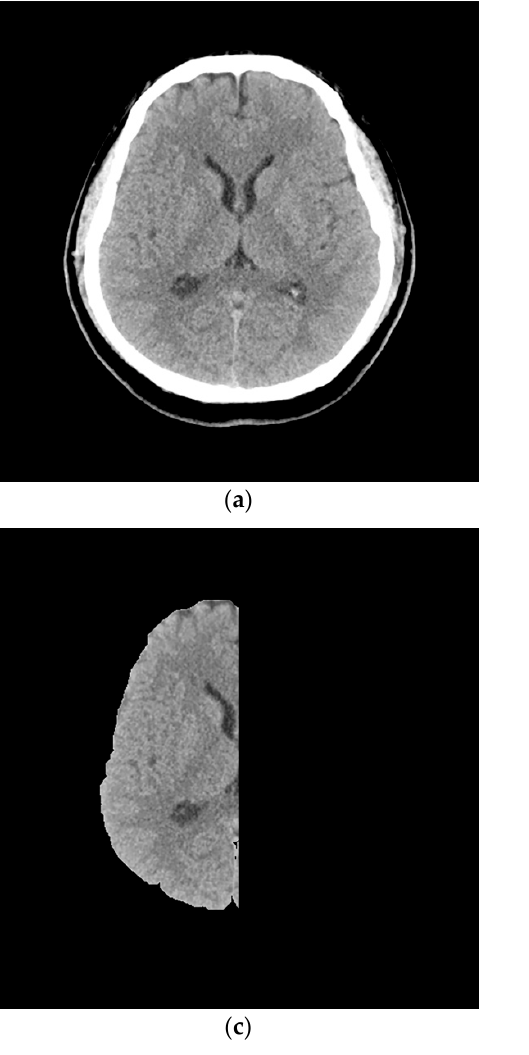
Figure 1. Image processing used to divide the left and right sides of the brain for symmetric comparisons. ( a ) The original non-contrast computed tomographic (NCCT) image, ( b ) the extracted brain area, ( c ) the left side, and ( d ) the right side.